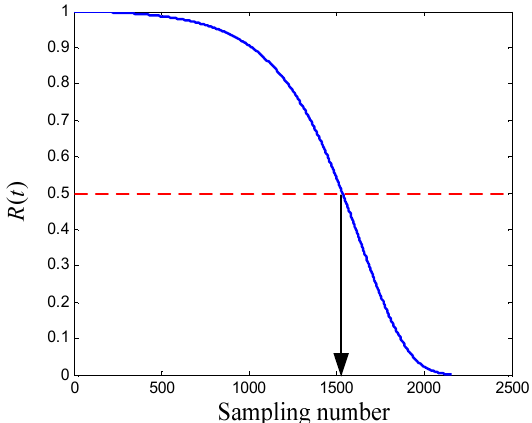
Figure 12. The estimated reliability of bearing B based on improved PCM.